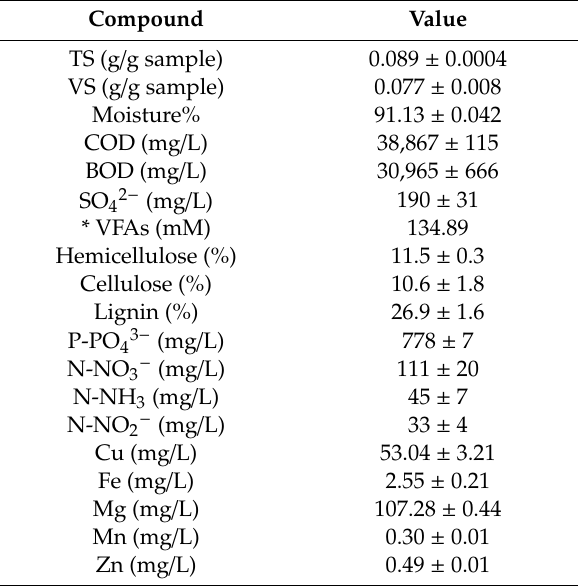
Table 2. Characteristics of pot ale as